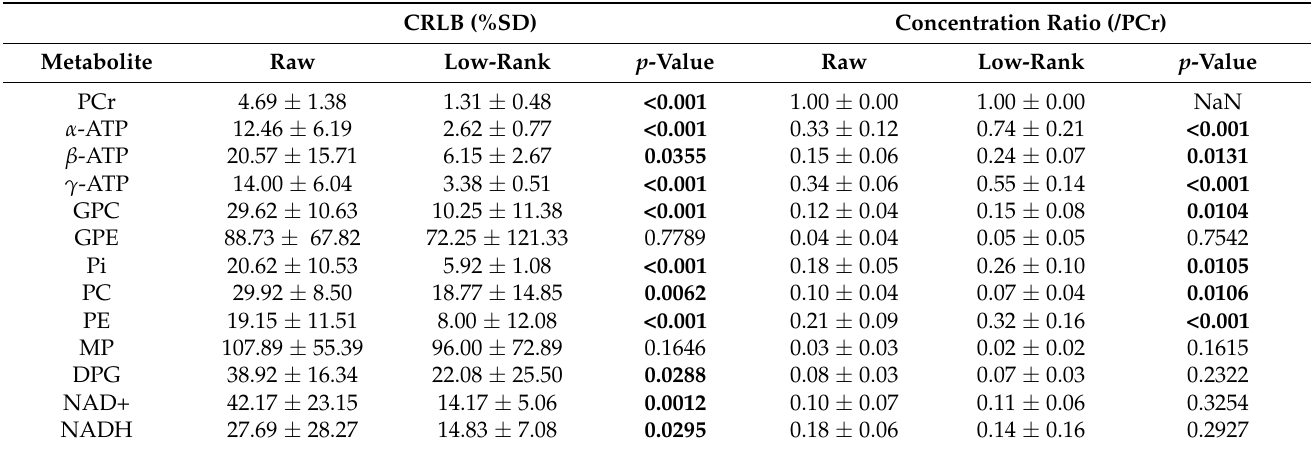
Table 2. CRLB and concentration differences between raw and denoised 31 P MRS